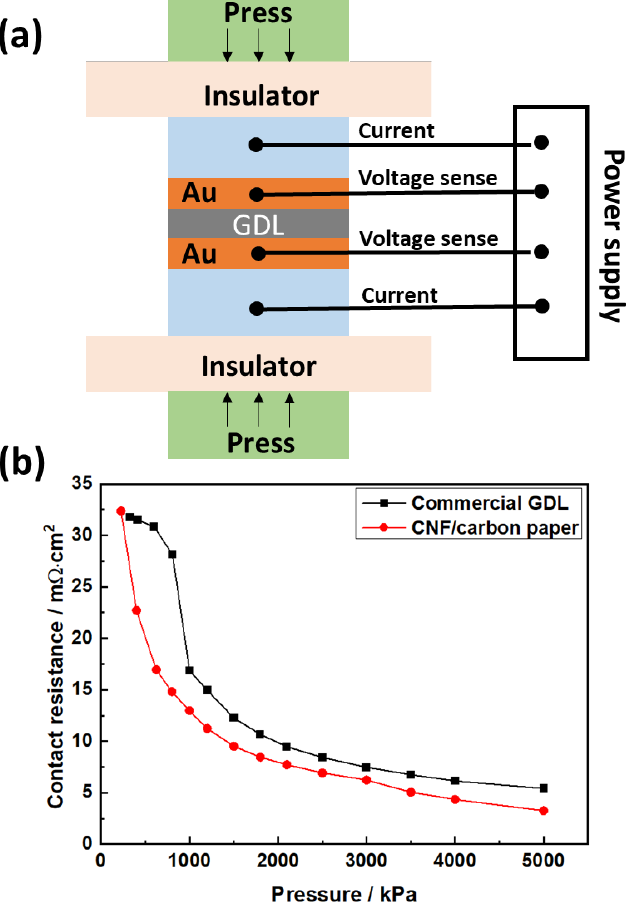
Figure 3. The through-plane resistance of hydrophobic commercial carbon paper ( a ) and CNF/carbon paper as a function of pressure ( b ).